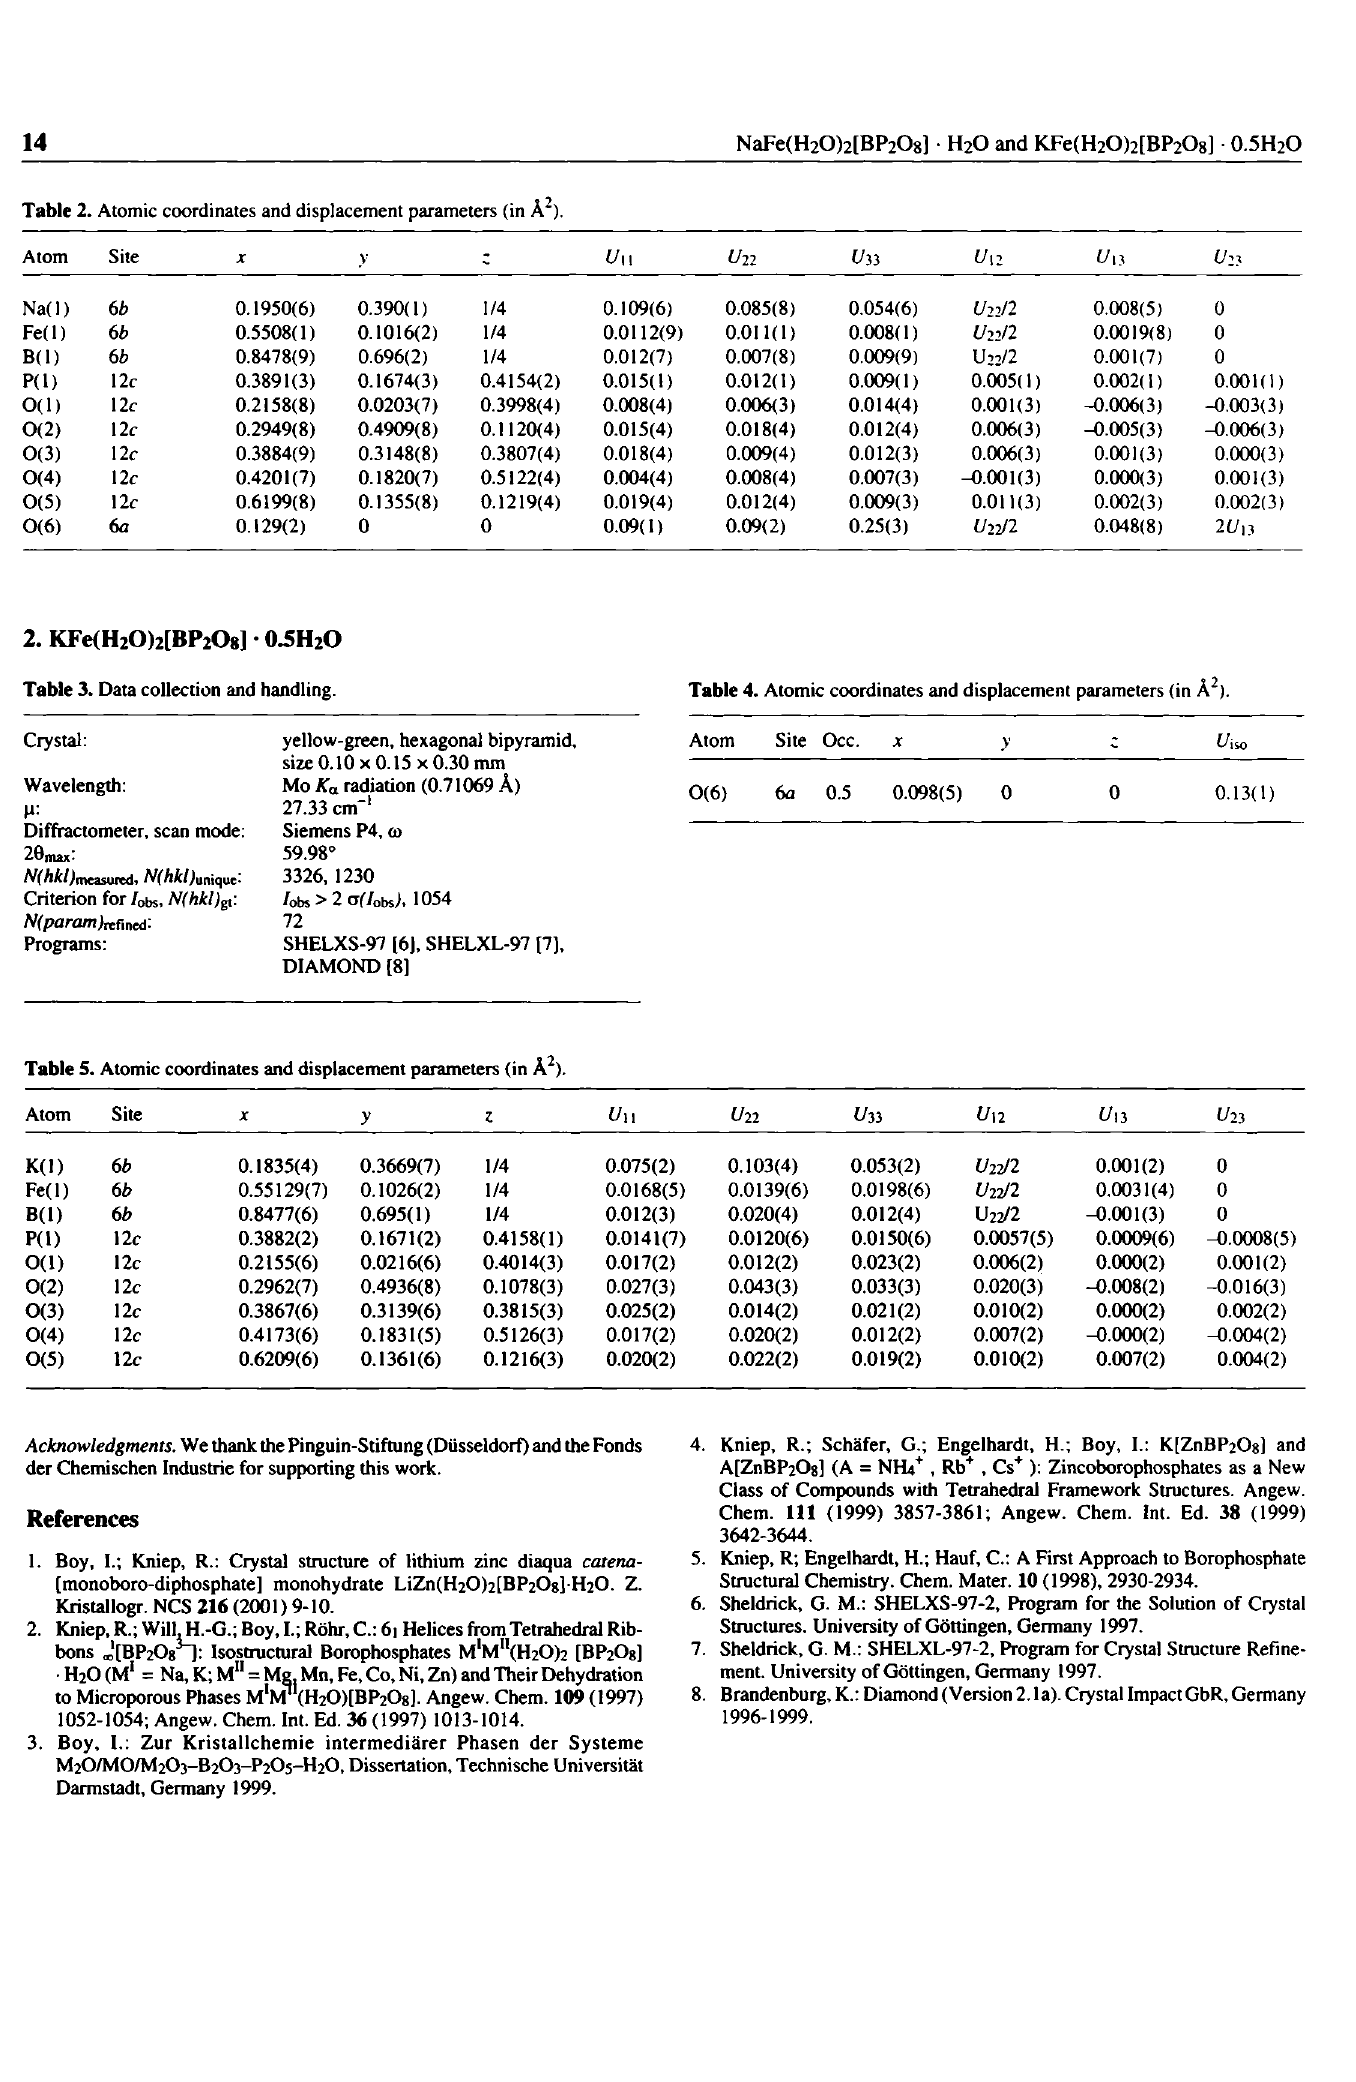
Table 2. Atomic coordinates and displacement parameters (in A 2 ).